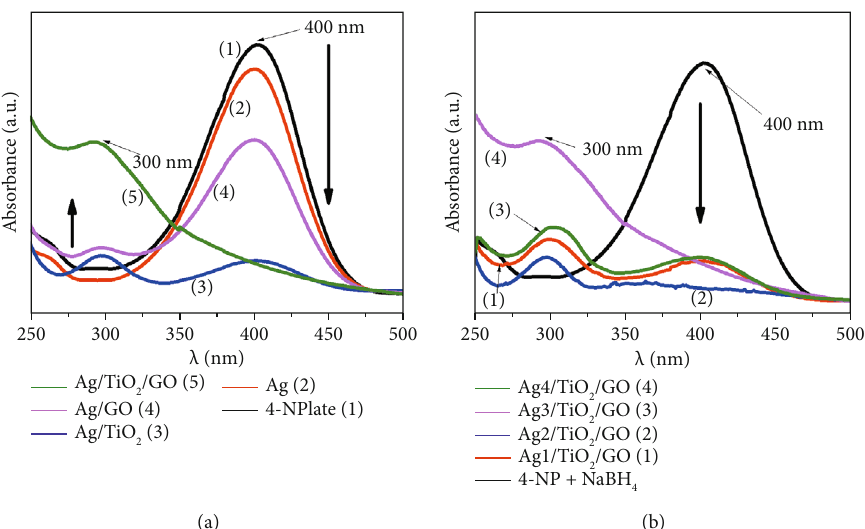
Figure 4: UV-Vis spectra of the catalytic reduction of 4-nitrophenolate (400nm) to 4-aminophenol (300nm) in the water and comparison of catalytic e ffi ciency of Ag, Ag/TiO , Ag/GO, and Ag/TiO /GO (a); comparison of catalytic e ffi ciency of varied contents of Ag in ATG Nces 2 2 (b).